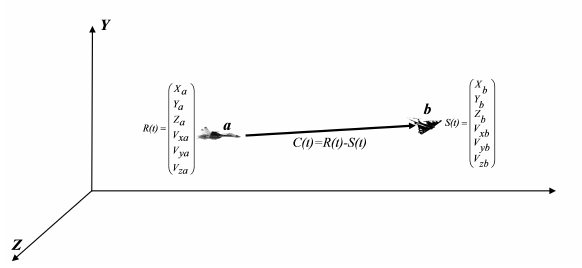
Figure 1: Illustration of the task formulation for avoidance of enemy